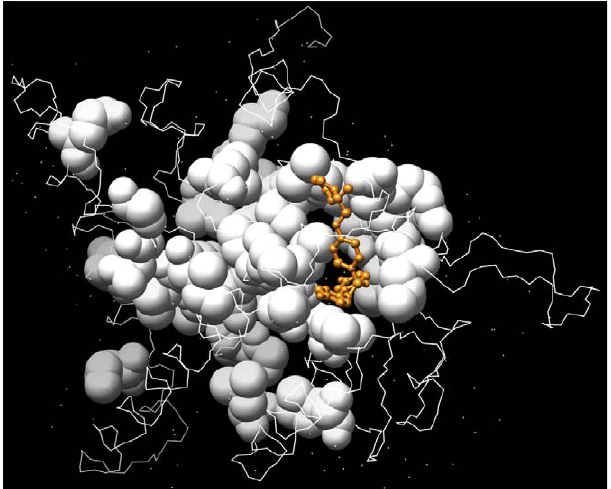
Figure 4. Predicated ER a Ligand Binding Site from Reverse Search by Querying the SERCA TG1 Site (White Spheres) The known bound ligand is shown in a ball-and-stick representation